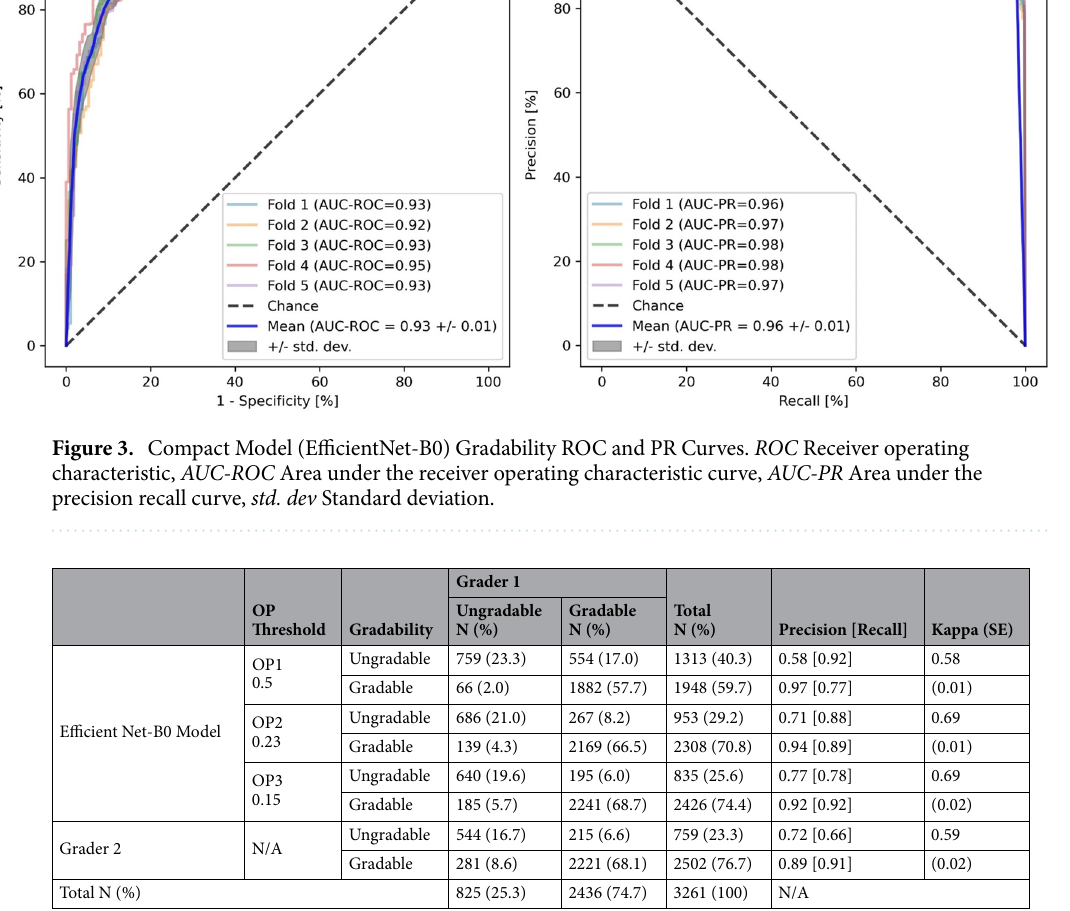
Table 2. Compact model (EfficientNet-B0) and grader performance. OP Operating point, SE Standard